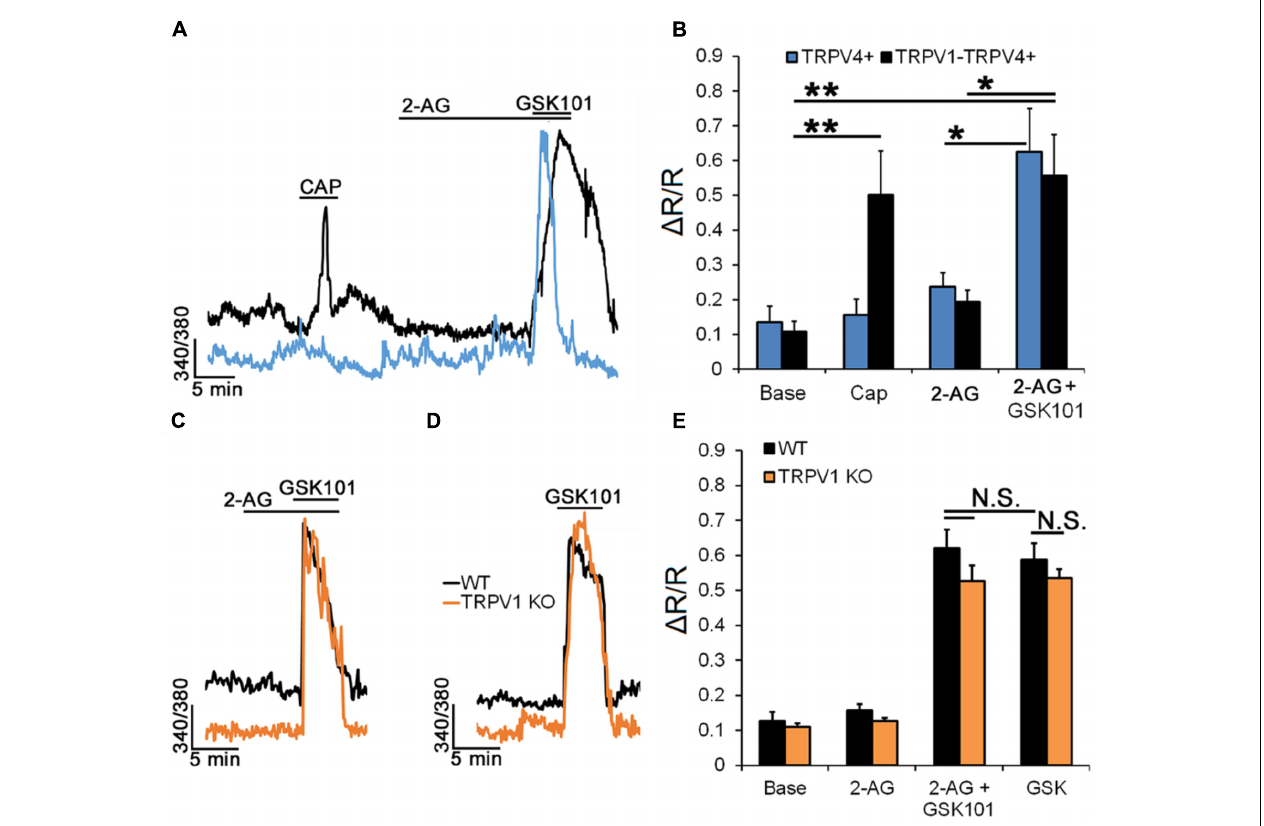
FIGURE 7 | RGC TRPV4 signaling is not modulated by endocannabinoids. Recordings from TRPV4 eGFP , wild type (C57), and TRPV1 − / − RGCs. (A) Representative traces and (B) cumulative averaged data for CAP and 2-AG responses in TRPV4 + ( n = 10) and TRPV1-TRPV4 + ( n = 10) RGCs. (C) Preincubation with 2-AG has no effect on the amplitude of the GSK101-evoked [Ca 2 + ] i response ( n = 24). (D) Ablation of the Trpv1 gene has no effect on the TRPV4 response ( n = 8). (E) Cumulative averaged data from WT (black) and TRPV1 (orange) KO RGCs. Neither exposure to 2-AG nor absence of TRPV1 impact GSK101-evoked [Ca 2 + ] i signaling. ∗ P ≤ 0.05, ∗∗ P ≤